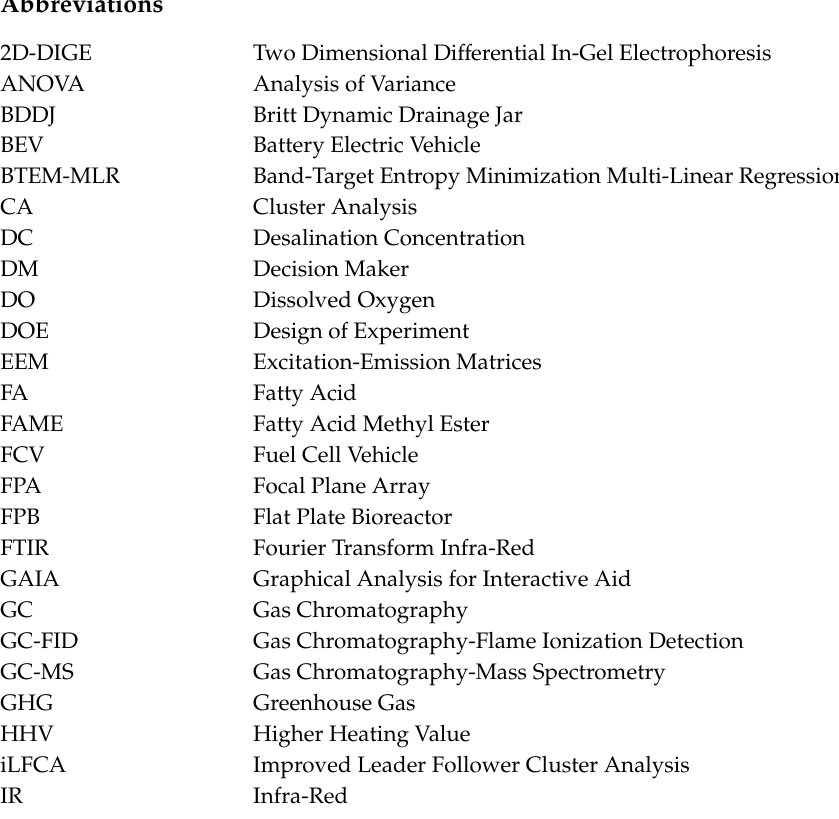
Table S1: Summary of chemometric methods applied in the production and processing of microalgae for biofuels. Author Contributions: Study conceptualization and design, M.M. and T.J.R.; writing—original draft